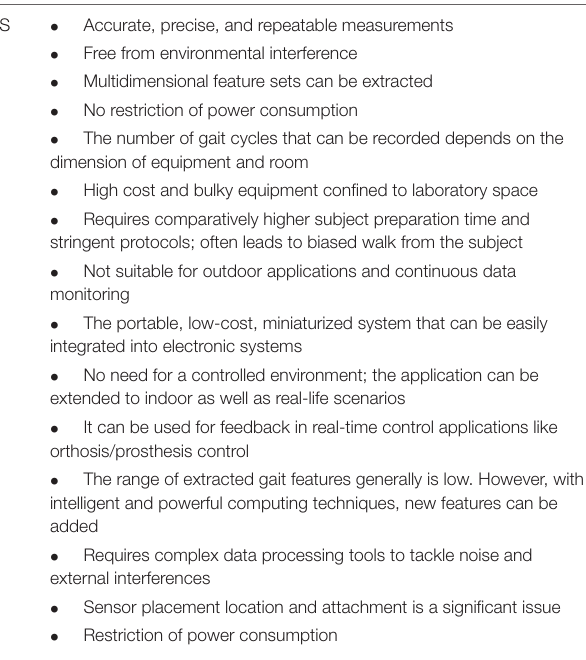
TABLE 1 | Comparison of NWS and WS measurement